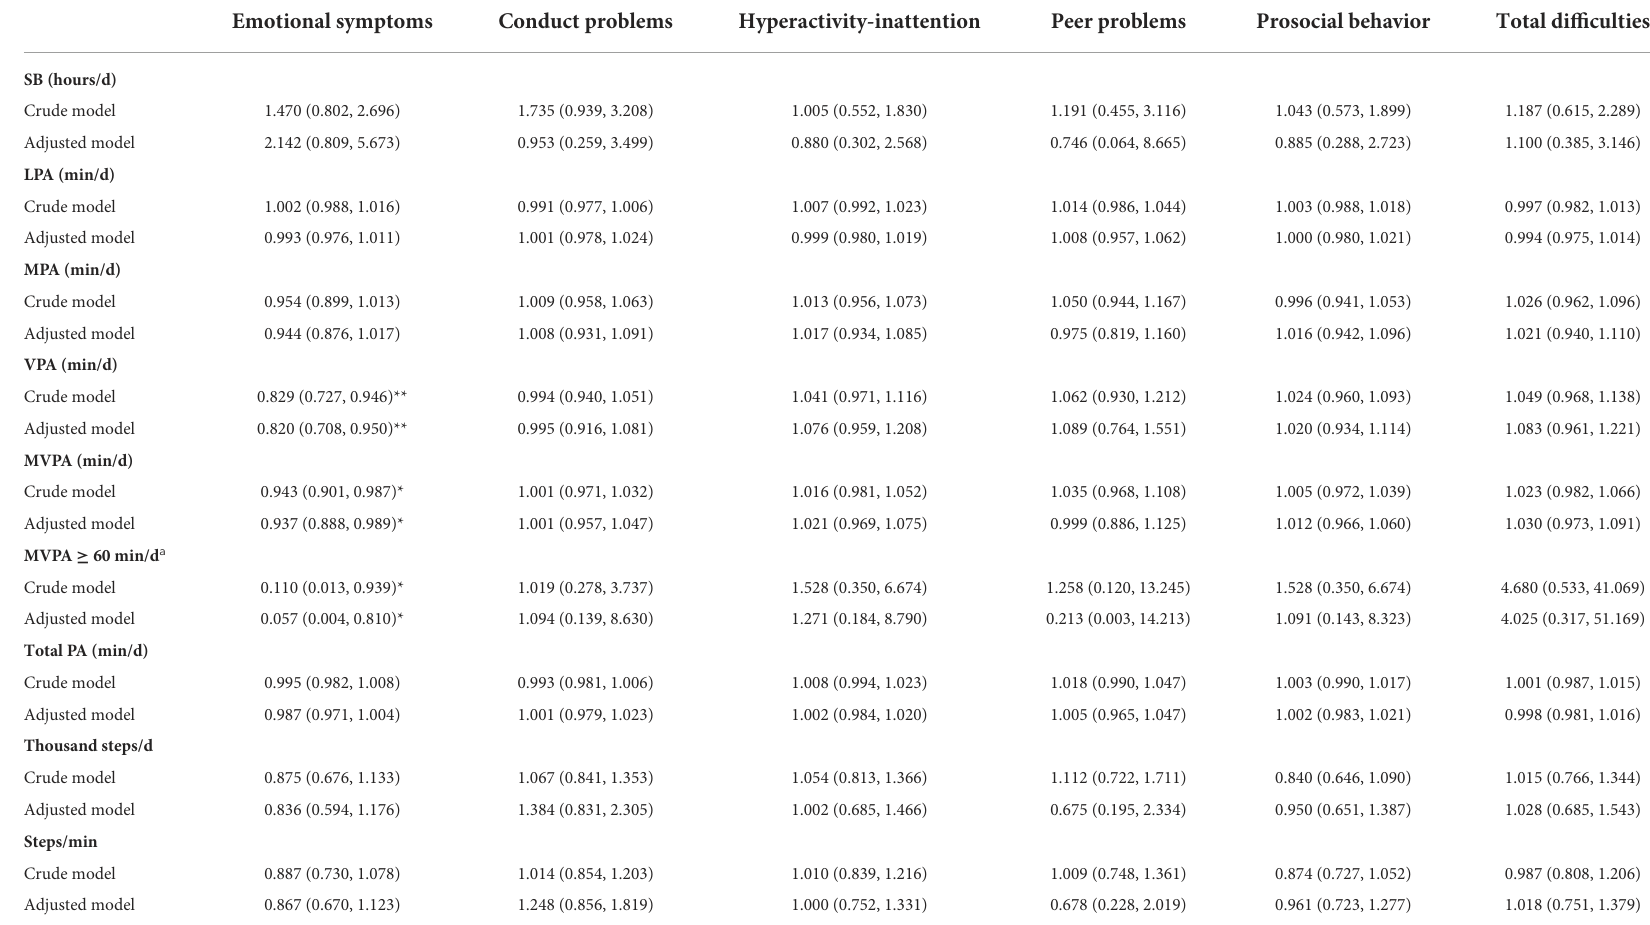
TABLE 4 Associations of emotional/behavioral problems (SDQ) with accelerometer-measured SB, PA, and step counts in children with ASD ( n =